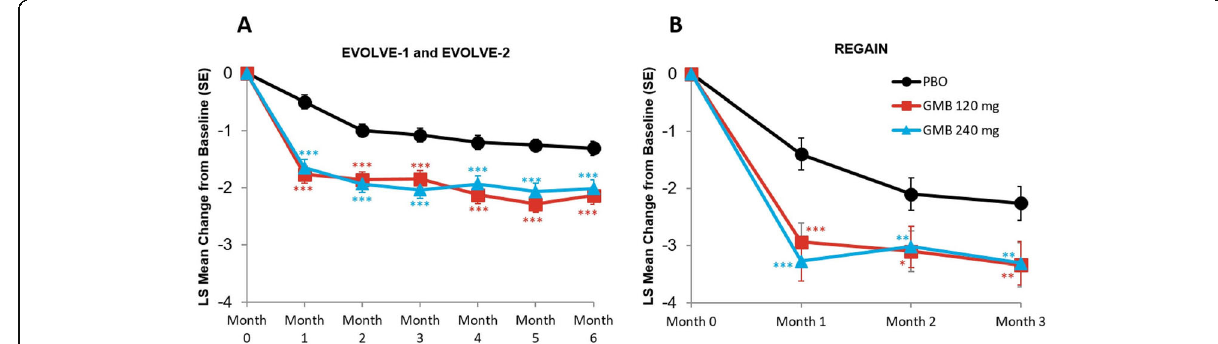
Fig. 1 Monthly mean change in monthly migraine headache days with nausea and/or vomiting. * p ≤ 0.05 vs PBO; ** p ≤ 0.01 vs PBO; *** p ≤ 0.001 vs PBO. GMB, galcanezumab; LS,least squares; PBO, placebo; SE, standard